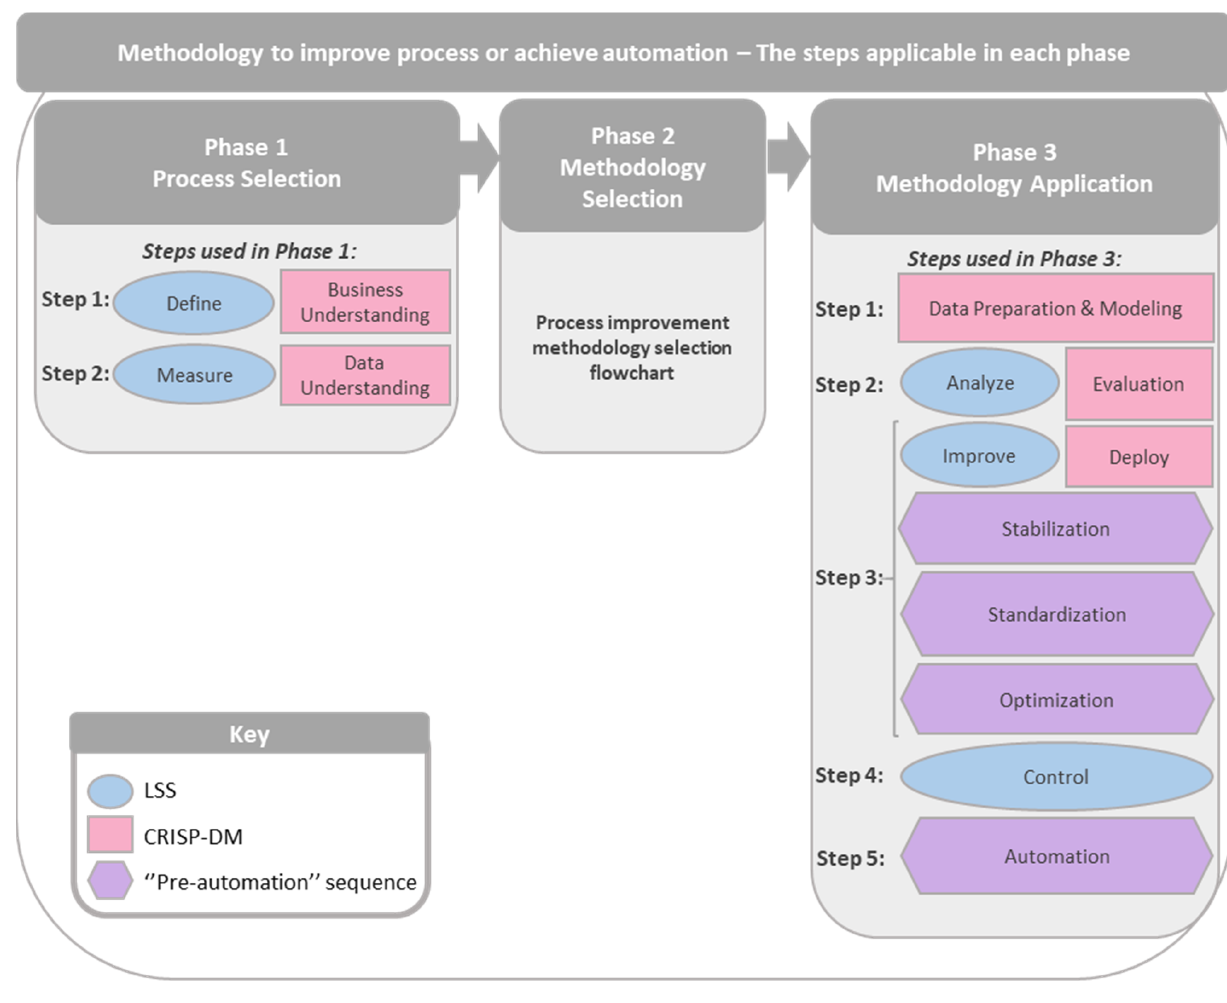
Figure 2. Methodology to achieve automation—the steps applicable in each phase.